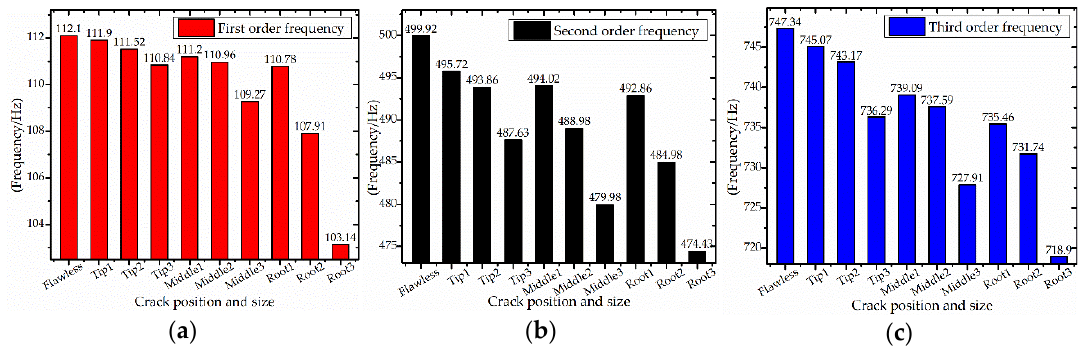
Figure 4. Blade modal frequency. ( a ) First order frequency; ( b ) Second order frequency; ( c ) Third order frequency.